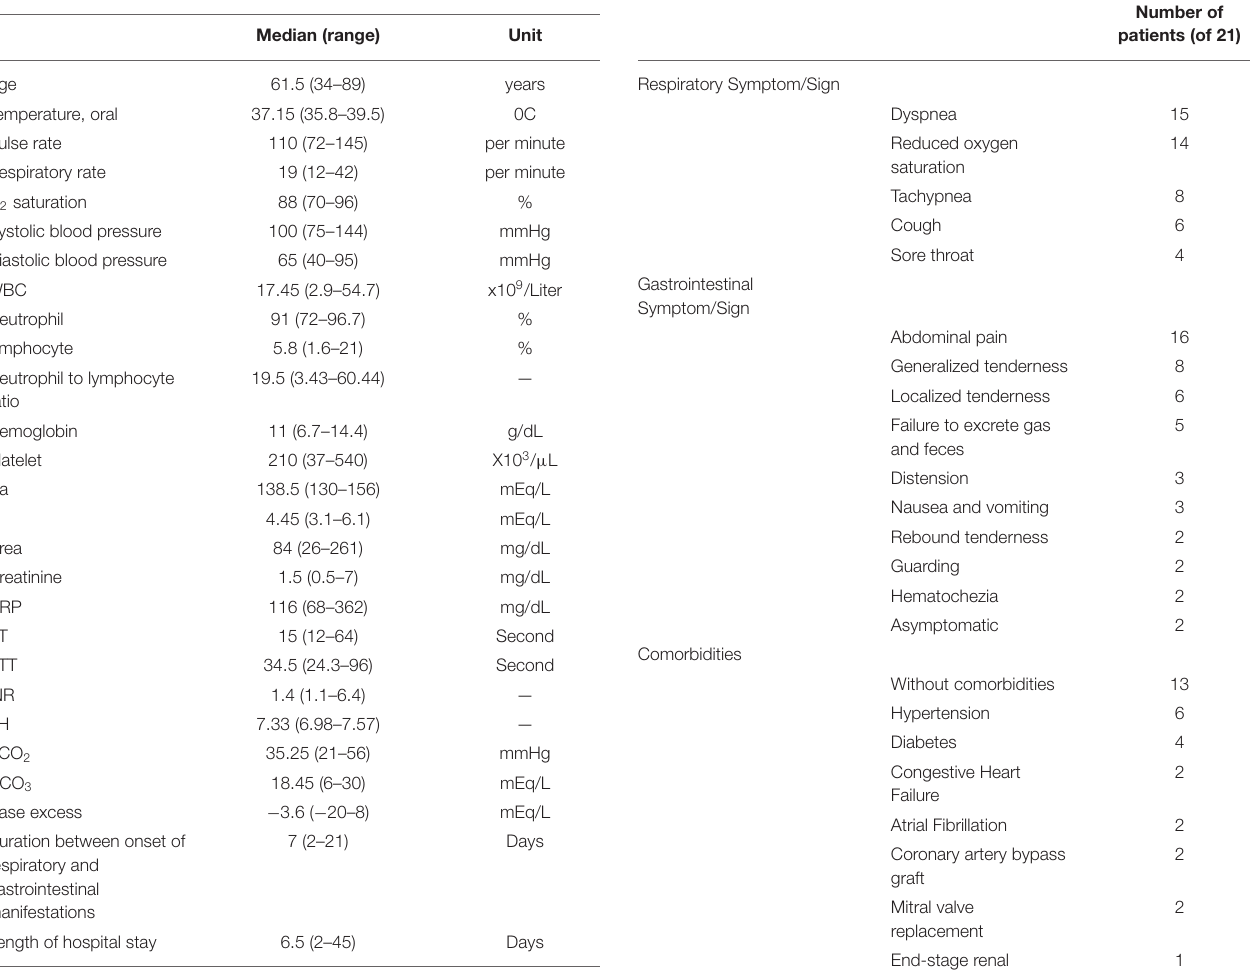
TABLE 1 | Baseline characteristics of the patients at the initiation of gastrointestinal manifestations.